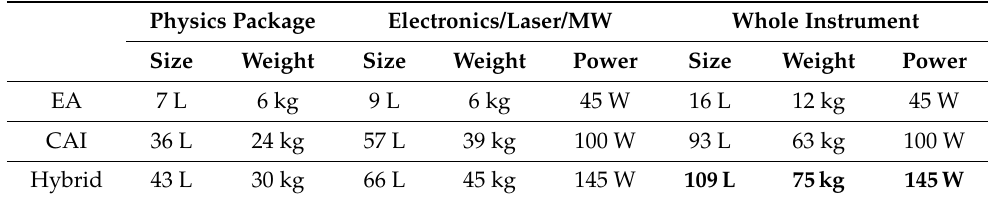
Table 6. Size, weight, and power budget for the hybrid instrument. Note that the CAI budget for the electronics, laser, and microwave system was extrapolated by taking into account the PHARAO’s flight model budget